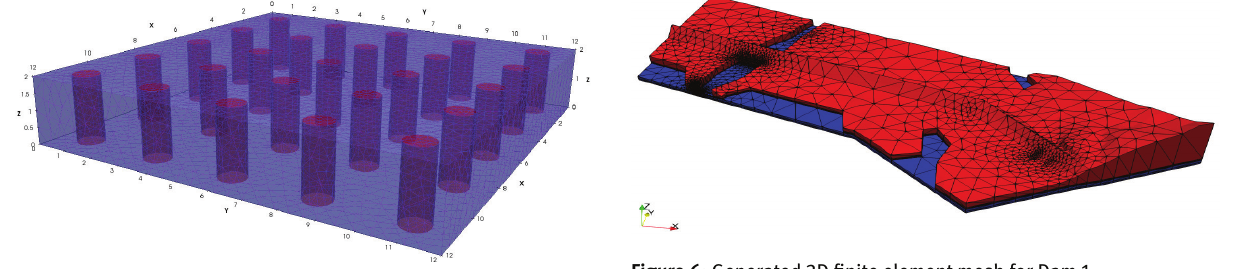
Figure 5: 3D view of the REV element along with the generated finite element mesh